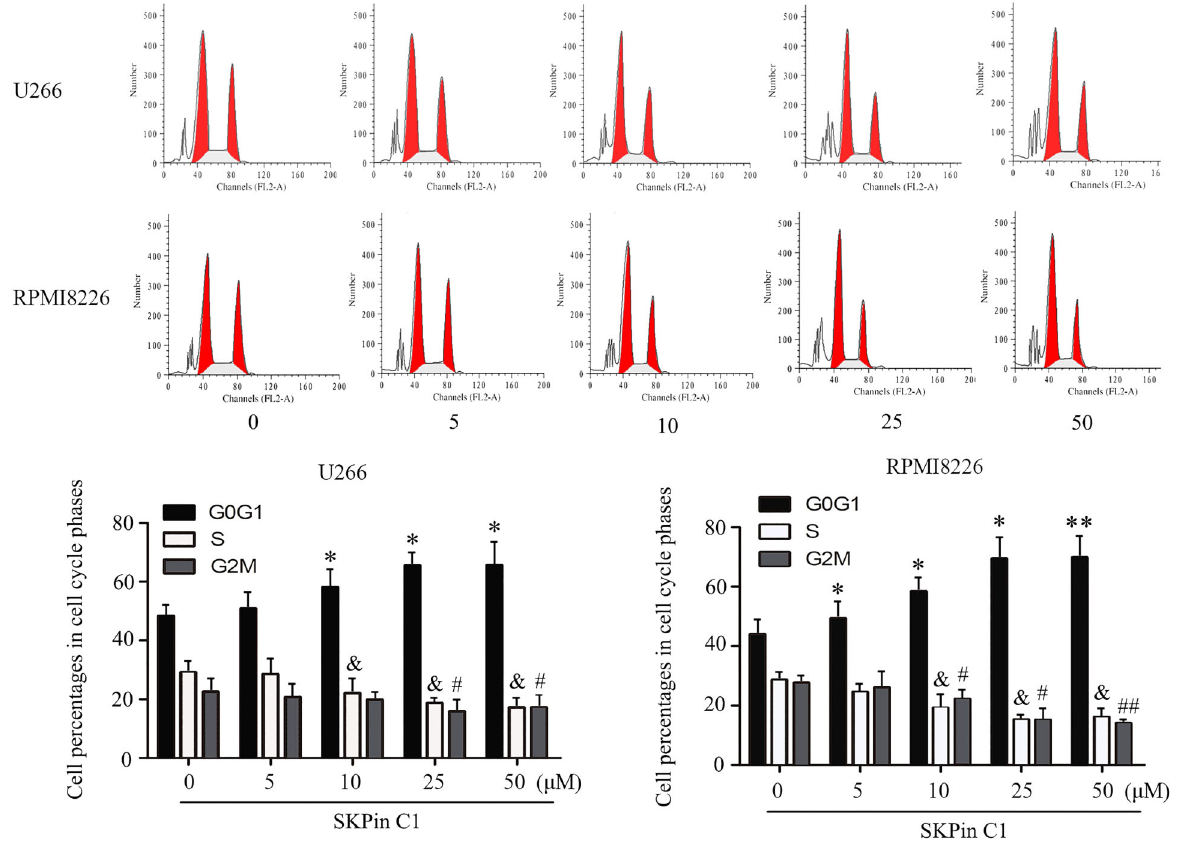
Figure 2. SKPin C1 retarded the cell cycle of U266 and RPMI 8226 cells. B lymphocytes, U266, and RPMI 8226 cells were subjected to different dosages of SKPin C1 for 12 h. The cell cycle was evaluated using fl ow cytometry analysis. Data are reported as means ± SD. *P o 0.05, **P o 0.01, # P o 0.05, ## P o 0.01, & P o 0.05 vs non-treatment group (control, 0 m M)